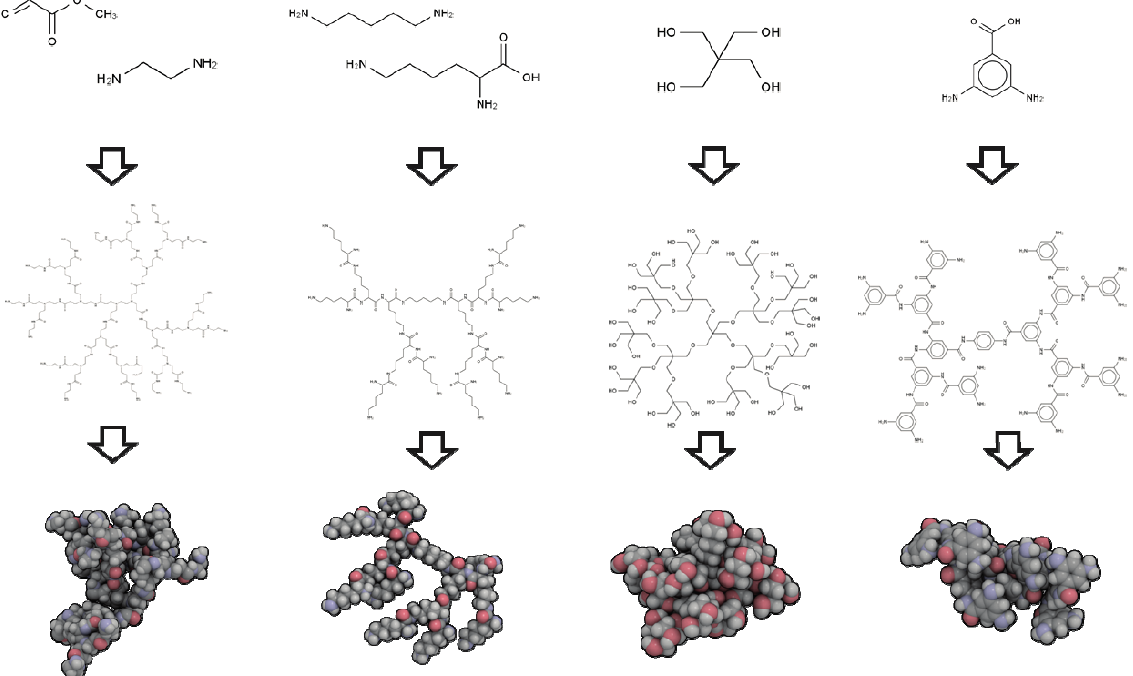
Figure 2. Topological structures obtained with different core and branching monomers; From top to bottom: monomeric units, 2D structure of a G2 dendrimer, 3D structure of G2